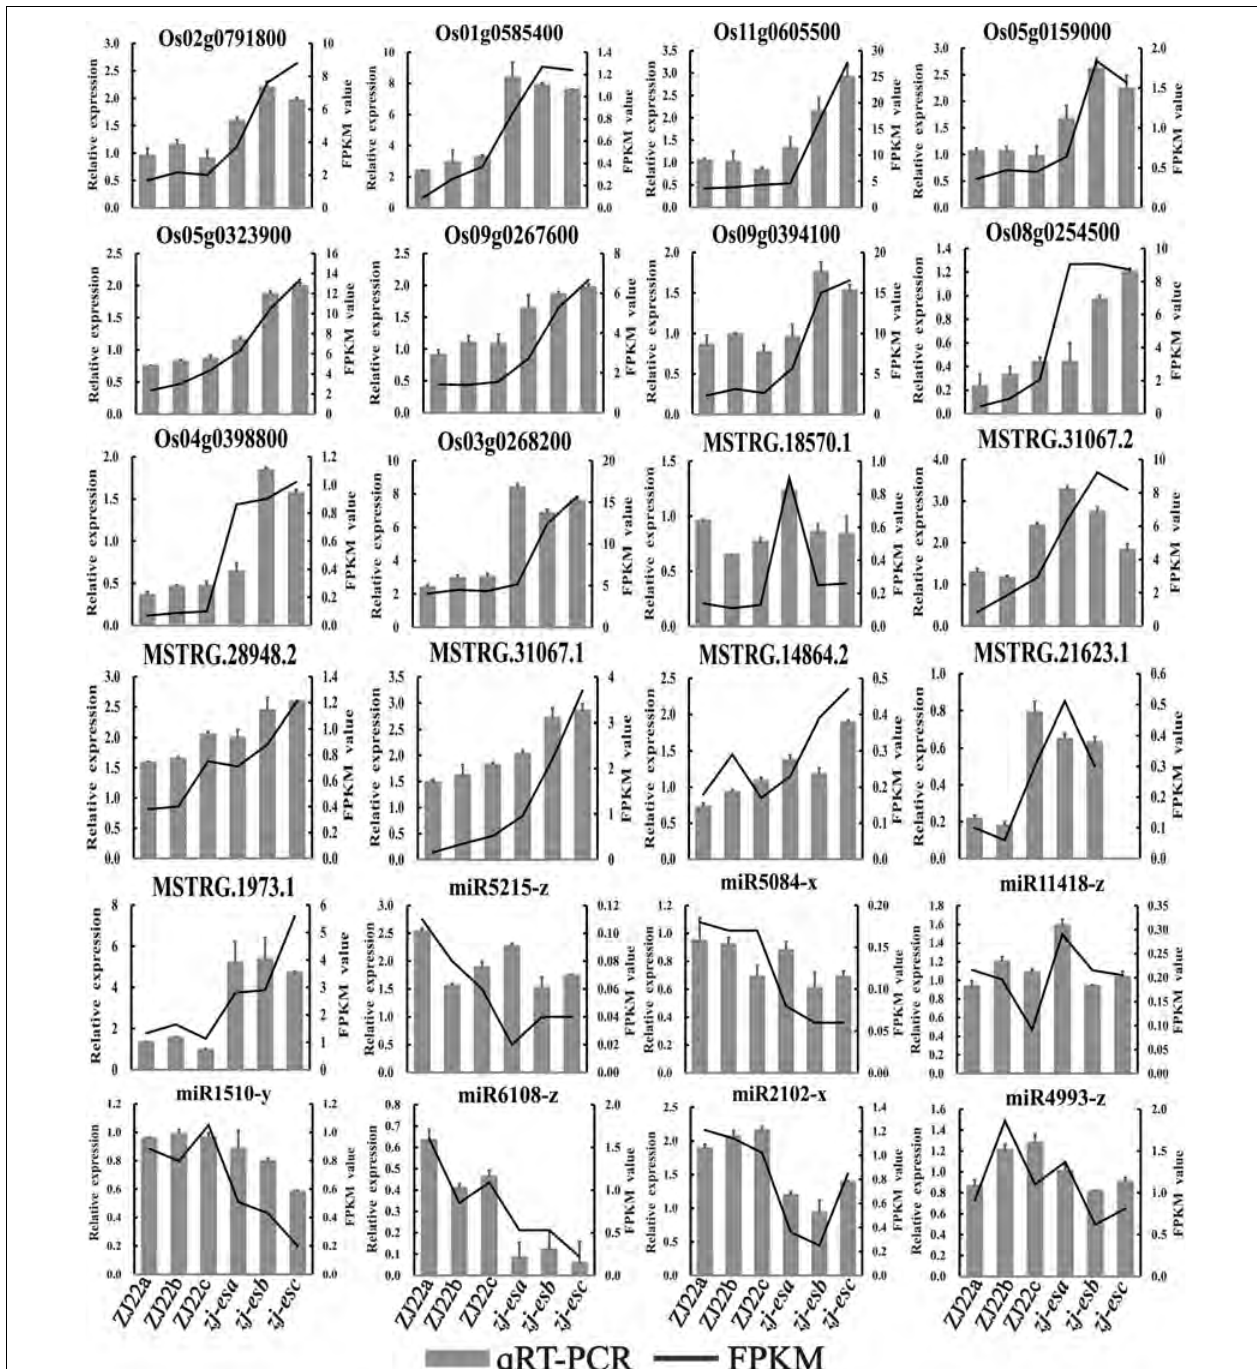
FIGURE 9 | The expression profiles of qRT-PCR were compared with the results of RNA-Seq analysis. The black line means FPKM, and the gray column means qRT-PCR.